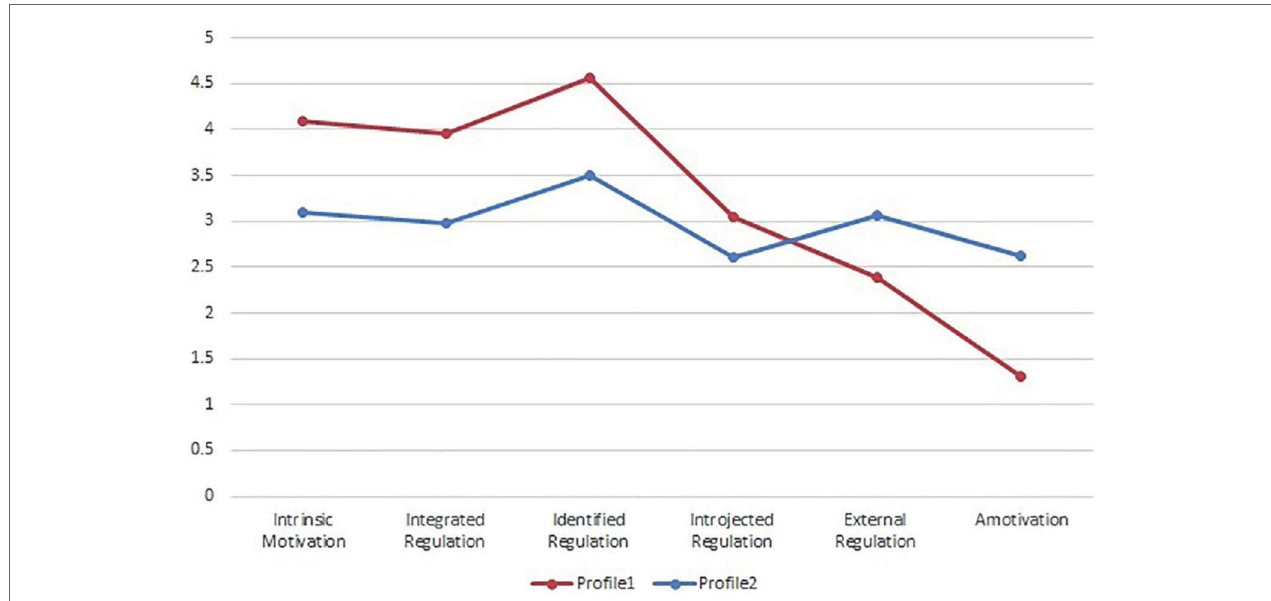
FIGURE 1 | Scores of the two motivation profiles for physical activity.